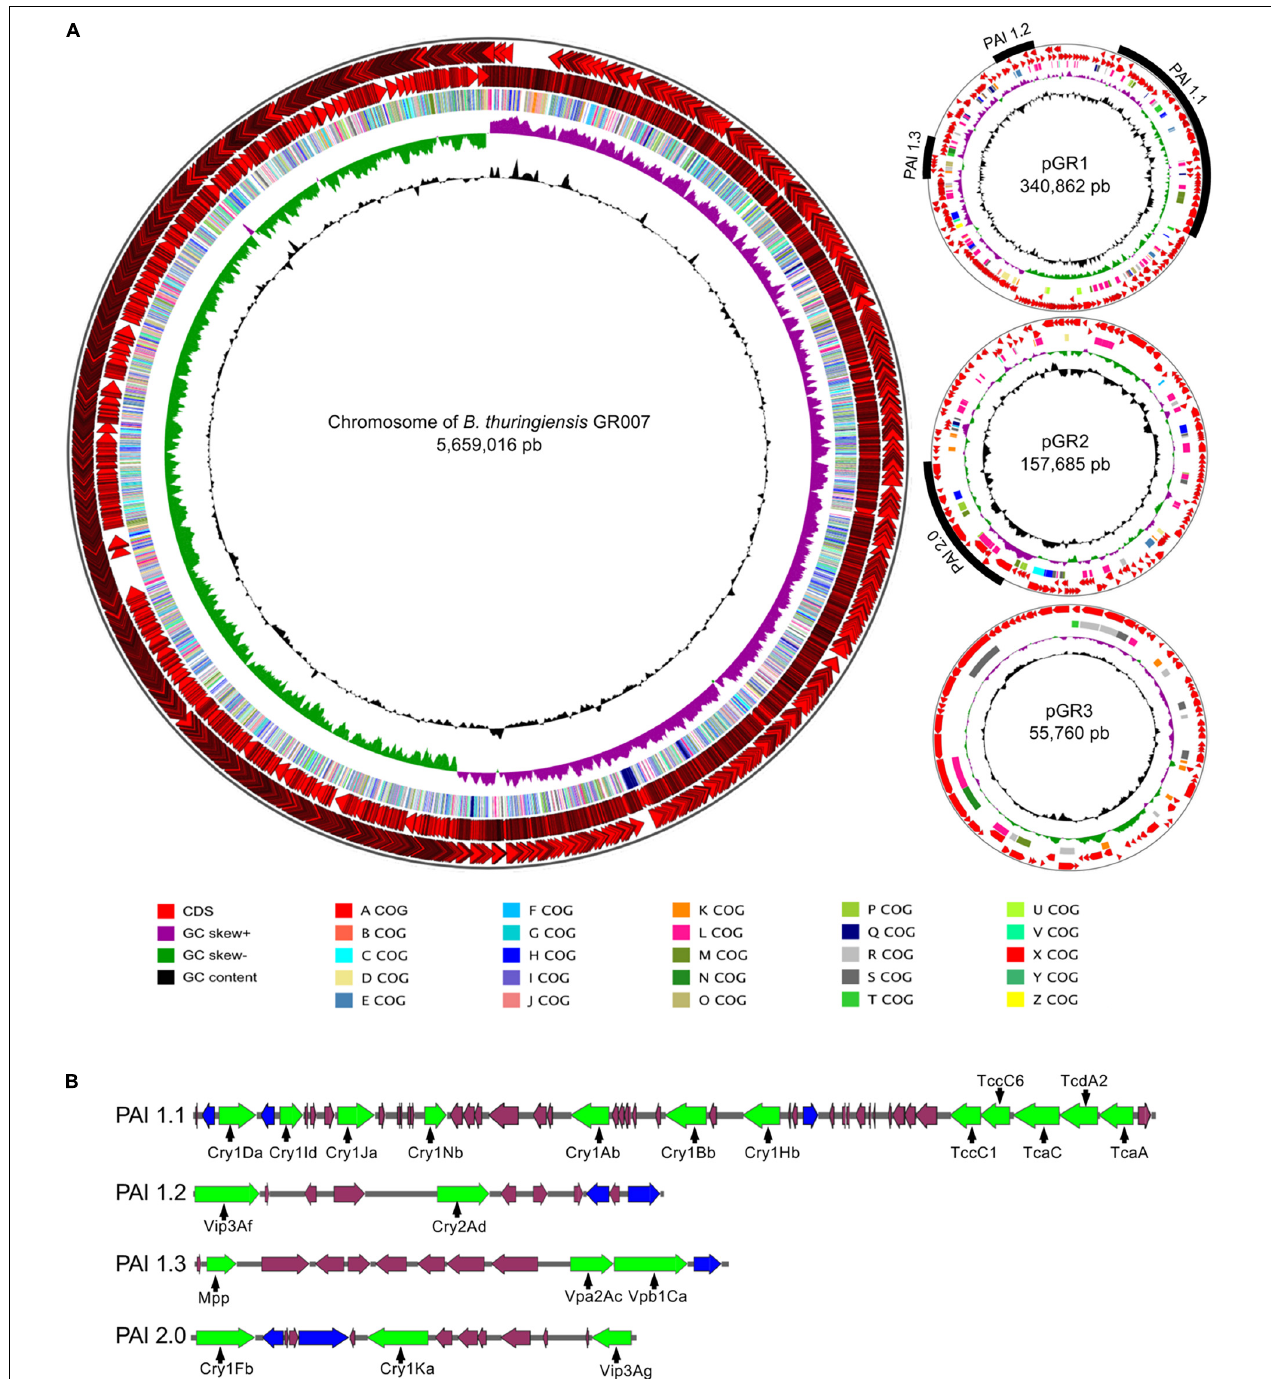
FIGURE 1 | Genome of B. thuringiensis strain GR007. (A) Circular maps of chromosome and plasmids. The distribution of circles from outside to inside indicate CDS forward, CDS reverse, COG functional assignation, GC skew, GC content. The pathogenic islands (PAI) identified are indicated in the plasmids pGR340 and pGR157. (B) Representation of PAIs. Pesticidal proteins are represented in green arrows, transposases in blue arrows and additional ORF into the PAIs with purple arrows.